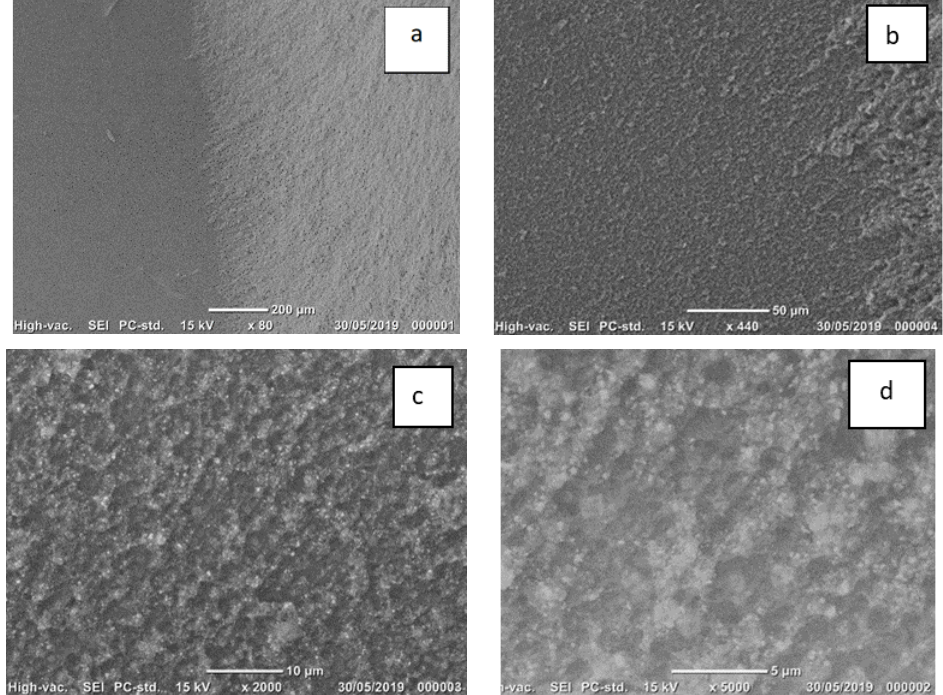
Figure 5. ( a – d ) — Scanning electron images of the mixed mode failure in a representative sample of Group 5 (EP). ( a , b ). In the uncovered ceramic surface, EP seems to produce fewer pronounced irregularities than HF (×440). ( c , d ). Lithium disilicate crystals are scarcely evident (×5000).